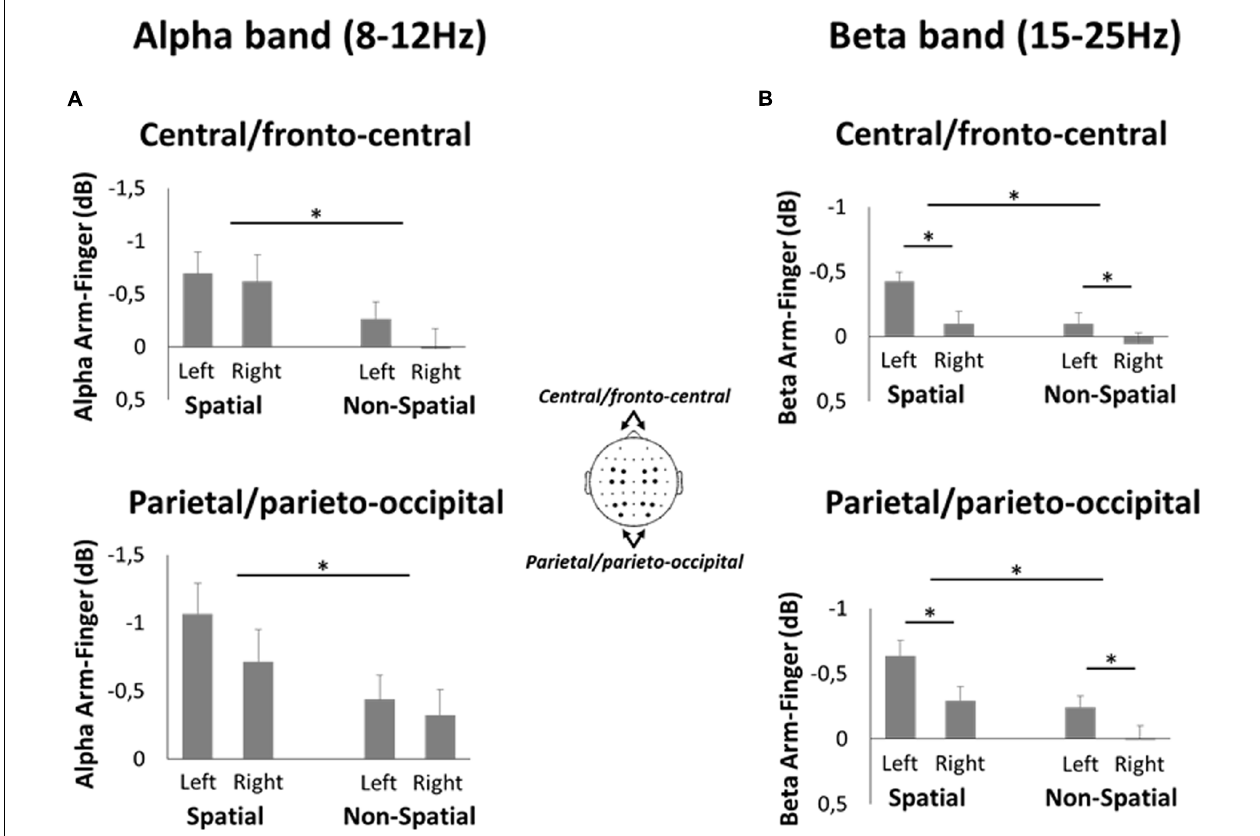
FIGURE 7 | Region of interest analysis in the EEG experiment. (A) Mean difference in alpha-band ERD during Spatial reach planning (Spatial Arm minus Spatial Finger) and Non-Spatial reach preparation (Non-Spatial Arm minus Non-Spatial Finger) at bilateral central/fronto-central electrodes (top panel) and parietal/parieto-occipital electrodes (bottom panel). (B) Same as A but for beta-band ERD. Asterisks denote a significant difference at p < 0.05.